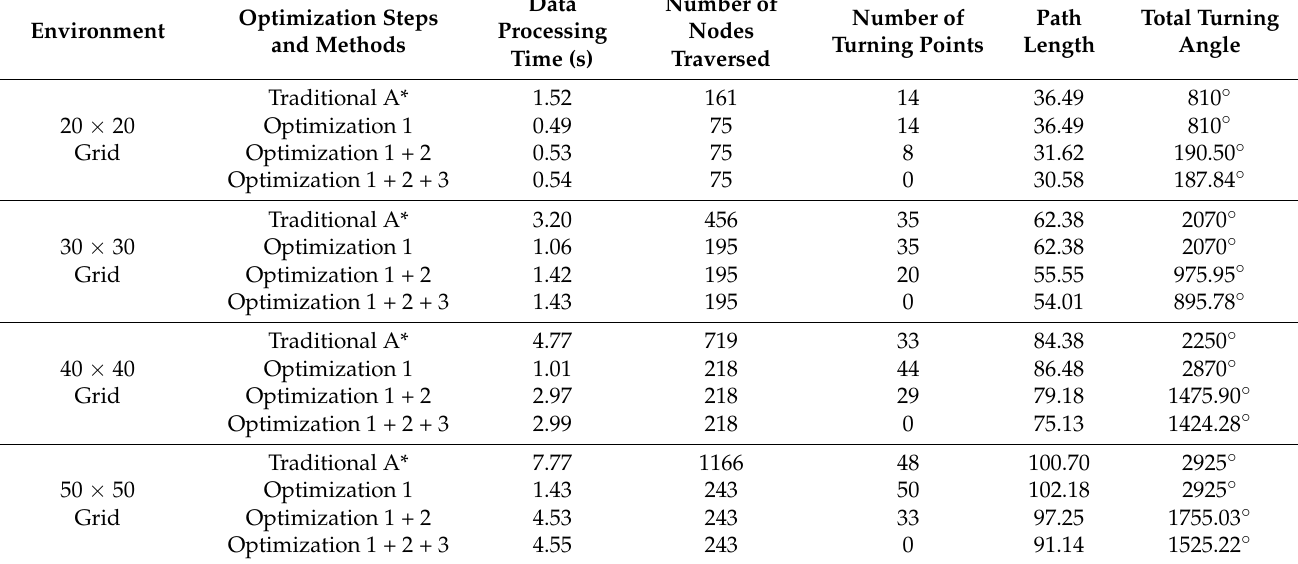
Table 2. Performance of the algorithms with different environments and optimization